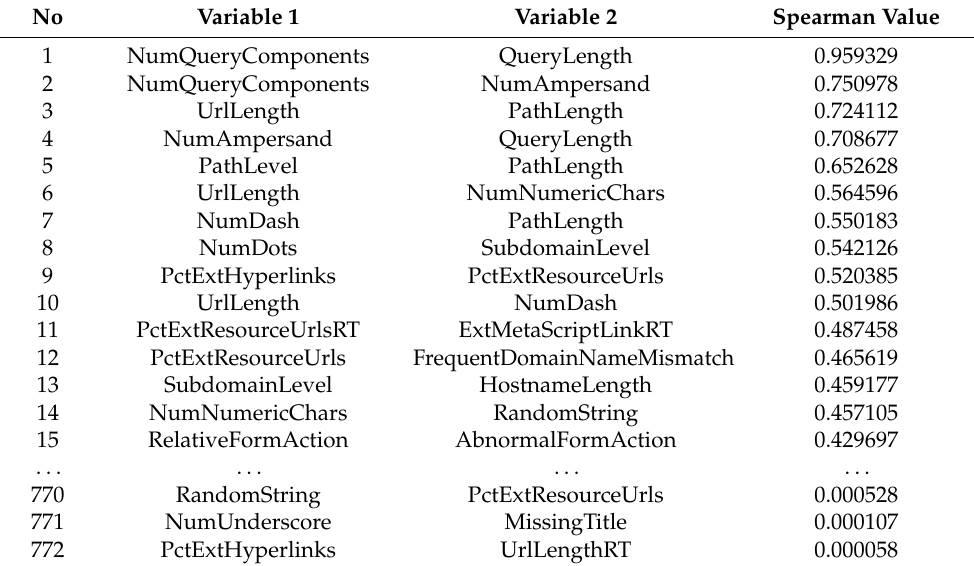
Table 11. Spearman correlation value between features on dataset 1.